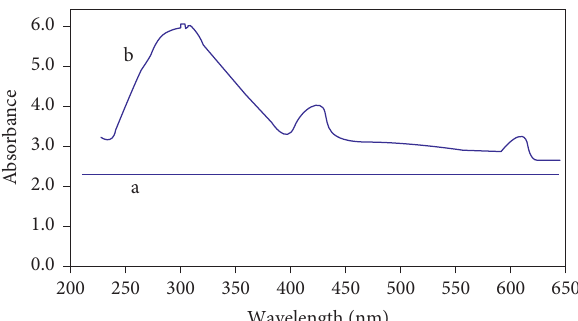
Figure 3: UV-Vis spectra of polyaniline-deposited cotton fibers in [(a) deionized water and (b) chloroform], respectively.